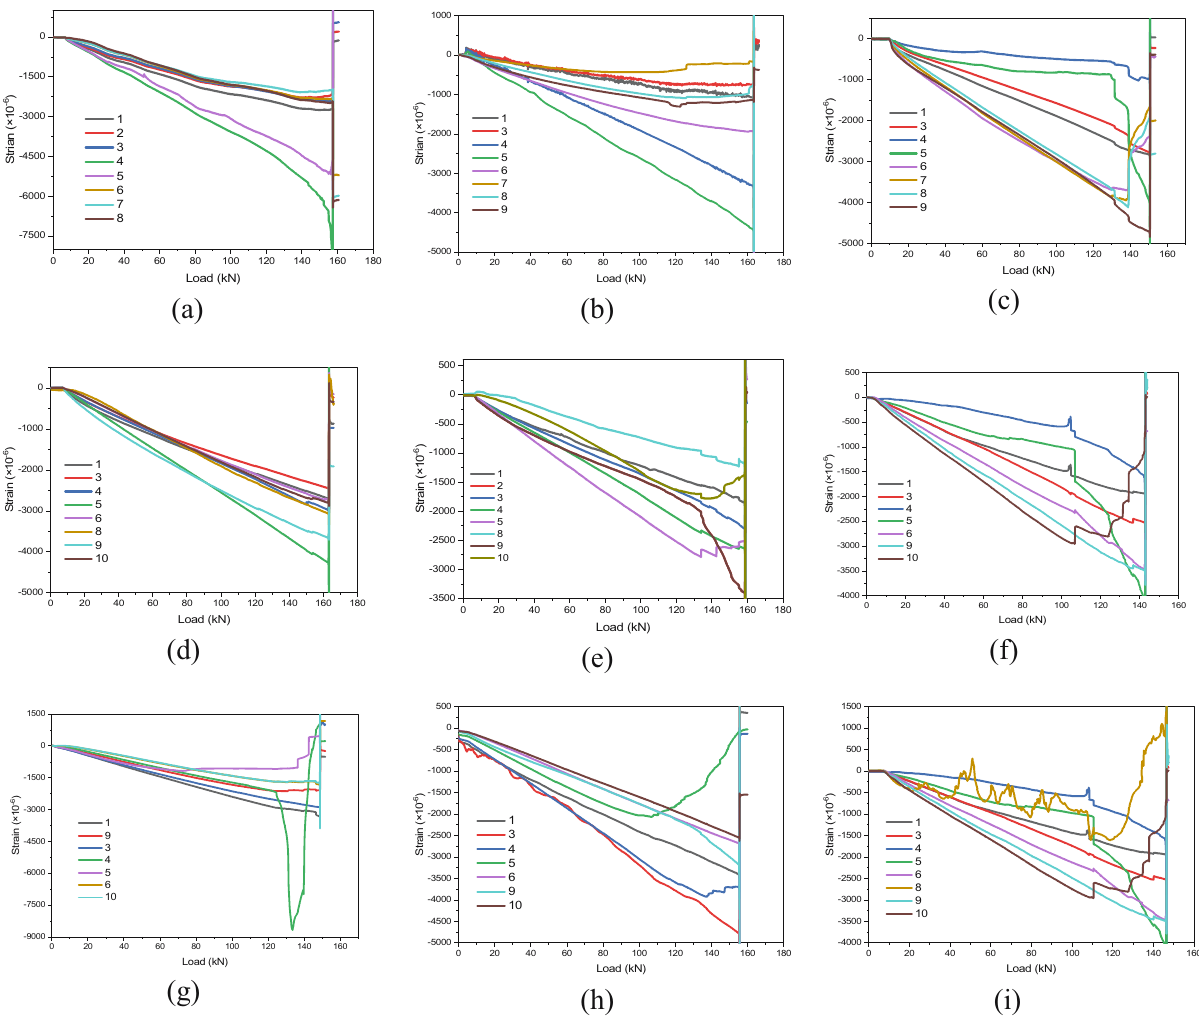
Figure 14: Specimen strain – load curves under 15 J impact: ( a ) #2; ( b ) #3; ( c ) #4; ( d ) #6; ( e ) #7; ( f ) #8; ( g ) #10; ( h ) #11; and ( i ) #12.